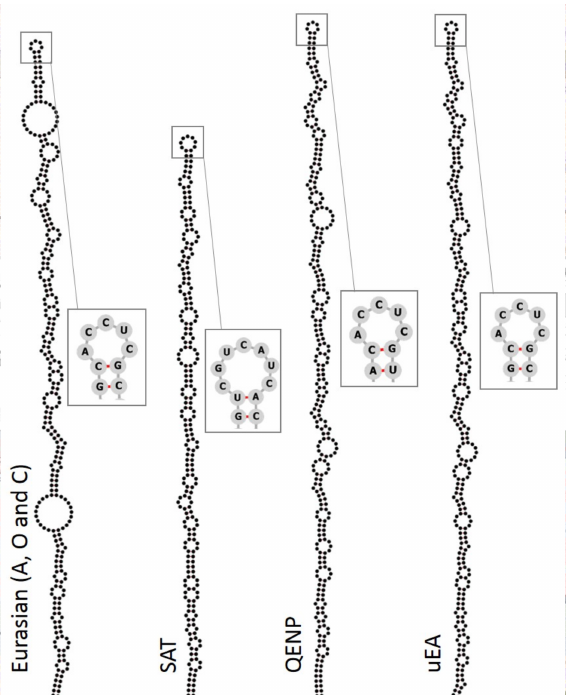
Figure 2. S-fragment sequences for QENP and uEA isolates can form single stem loops with similar secondary RNA structure as the S-fragments of other FMDV isolates. Separate multiple sequence alignments (MSAs) were prepared for sequences of Eurasian, SAT, QENP and uEA clusters using X-INS-i algorithm implemented in the MAFFT package. Secondary structure prediction was calculated using RNAalifold algorithm implemented in the ViennaRNA package and structures were visualized in the Forna visualization server. Sequencing of the FMDV genome often results in ambiguity at the beginning of the genome and at regions flanking the poly(C) region, therefore only regions of the S-fragment which showed unique base calling for the whole alignment were included in these RNA secondary structure predictions. Sequence at the apex of each conserved RNA secondary structure is shown, where pairing between two nucleotides is highlighted in